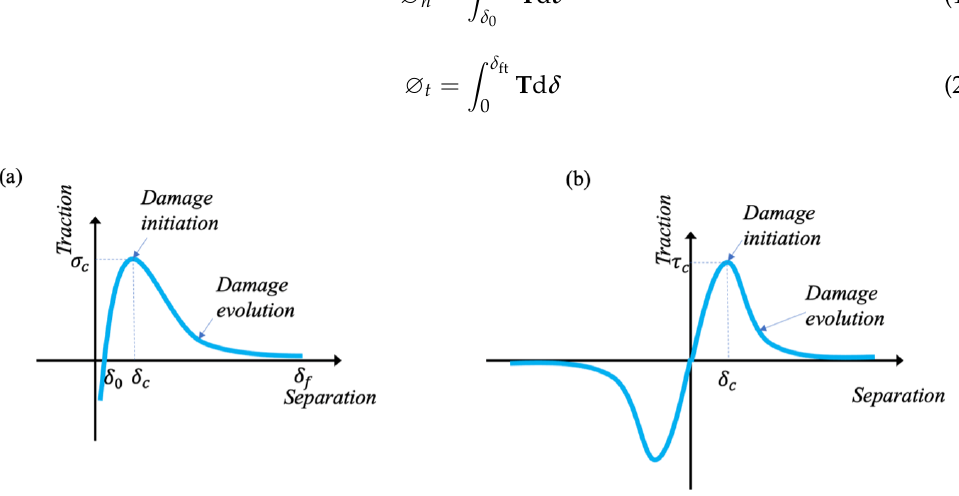
Figure 2. Traction–separation relations used to describe interfacial behaviors: ( a ) normal direction; ( b ) tangential